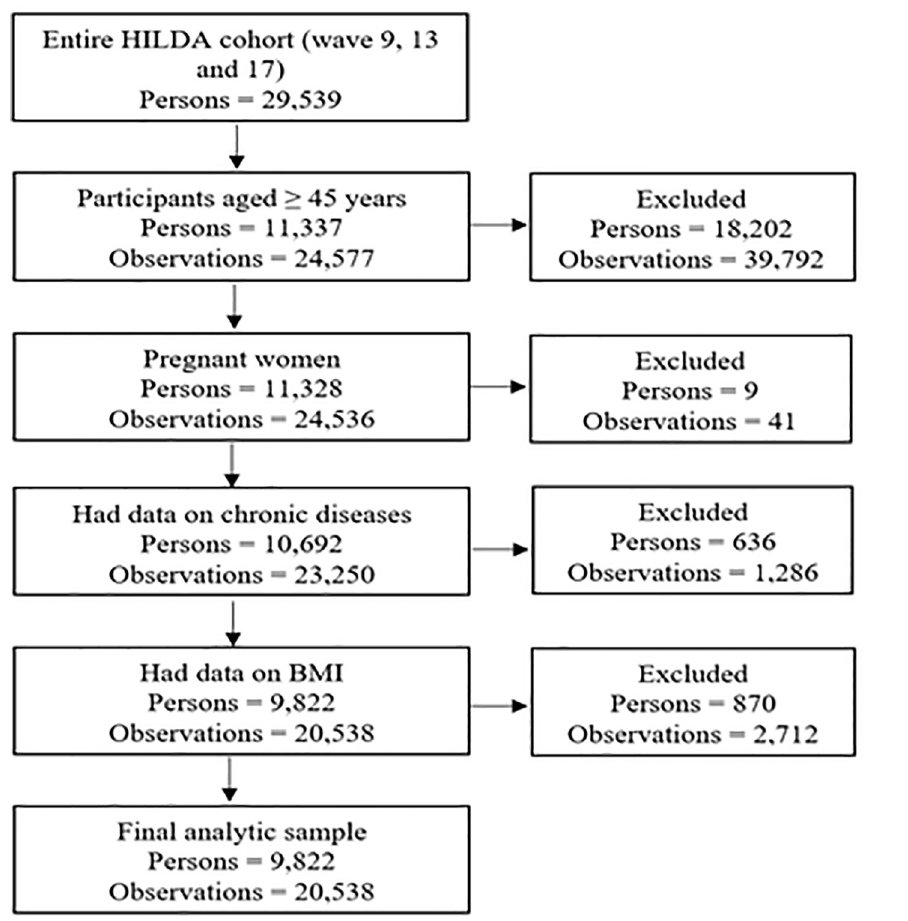
Fig 1. Flow chart of sample selection and missing